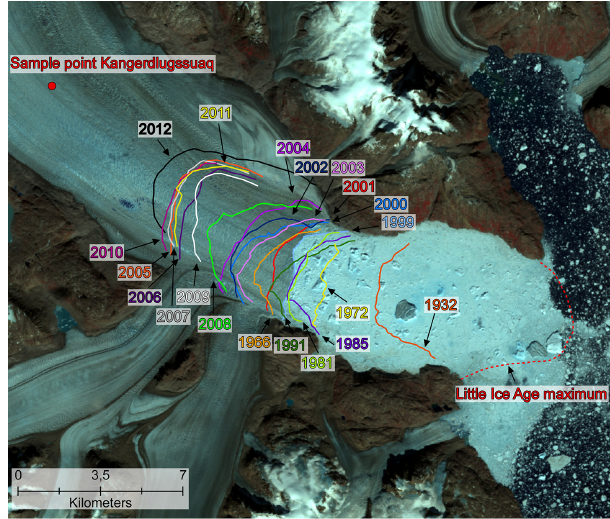
Figure 8. Frontal position of Helheim Glacier adopted from Bjørk et al. (2012). Oblique aerial image (1933), Vertical aerial image (1943), Corona satellite (1965), Landsat 1 Multi-Spectral Scan- ner (MSS) (1972 and 1979), Vertical aerial image (1981), Land- sat 5 Thematic Mapper (TM) (1985, 1986, 1992), Landsat 7 ETM+ (1999–2012). The red circle represents the location of the time se- ries shown in Fig. 7a.